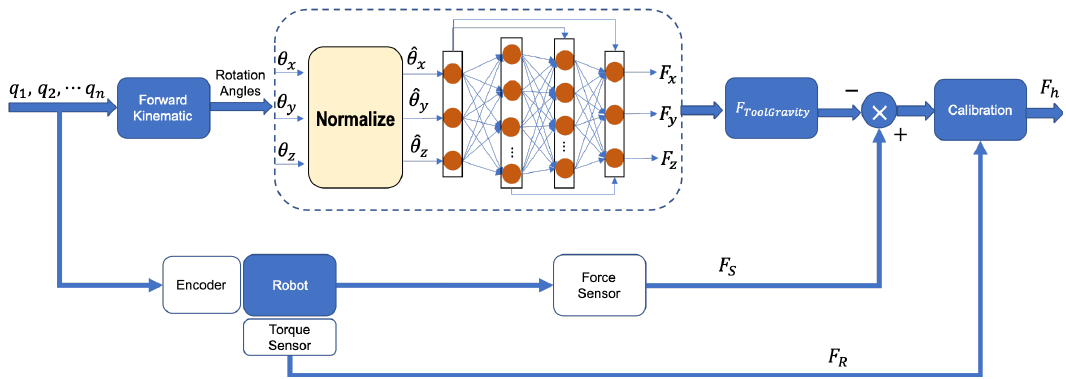
Figure 6. Overview of the identification and calibration procedure using